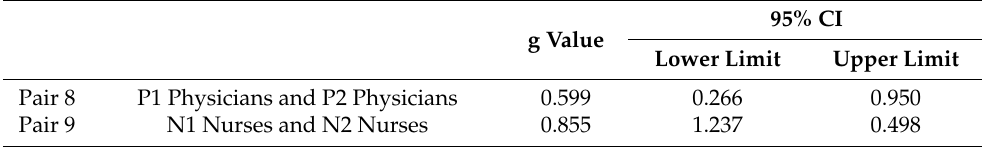
Table 8. Effect sizes for Hedge’s g dependent samples.